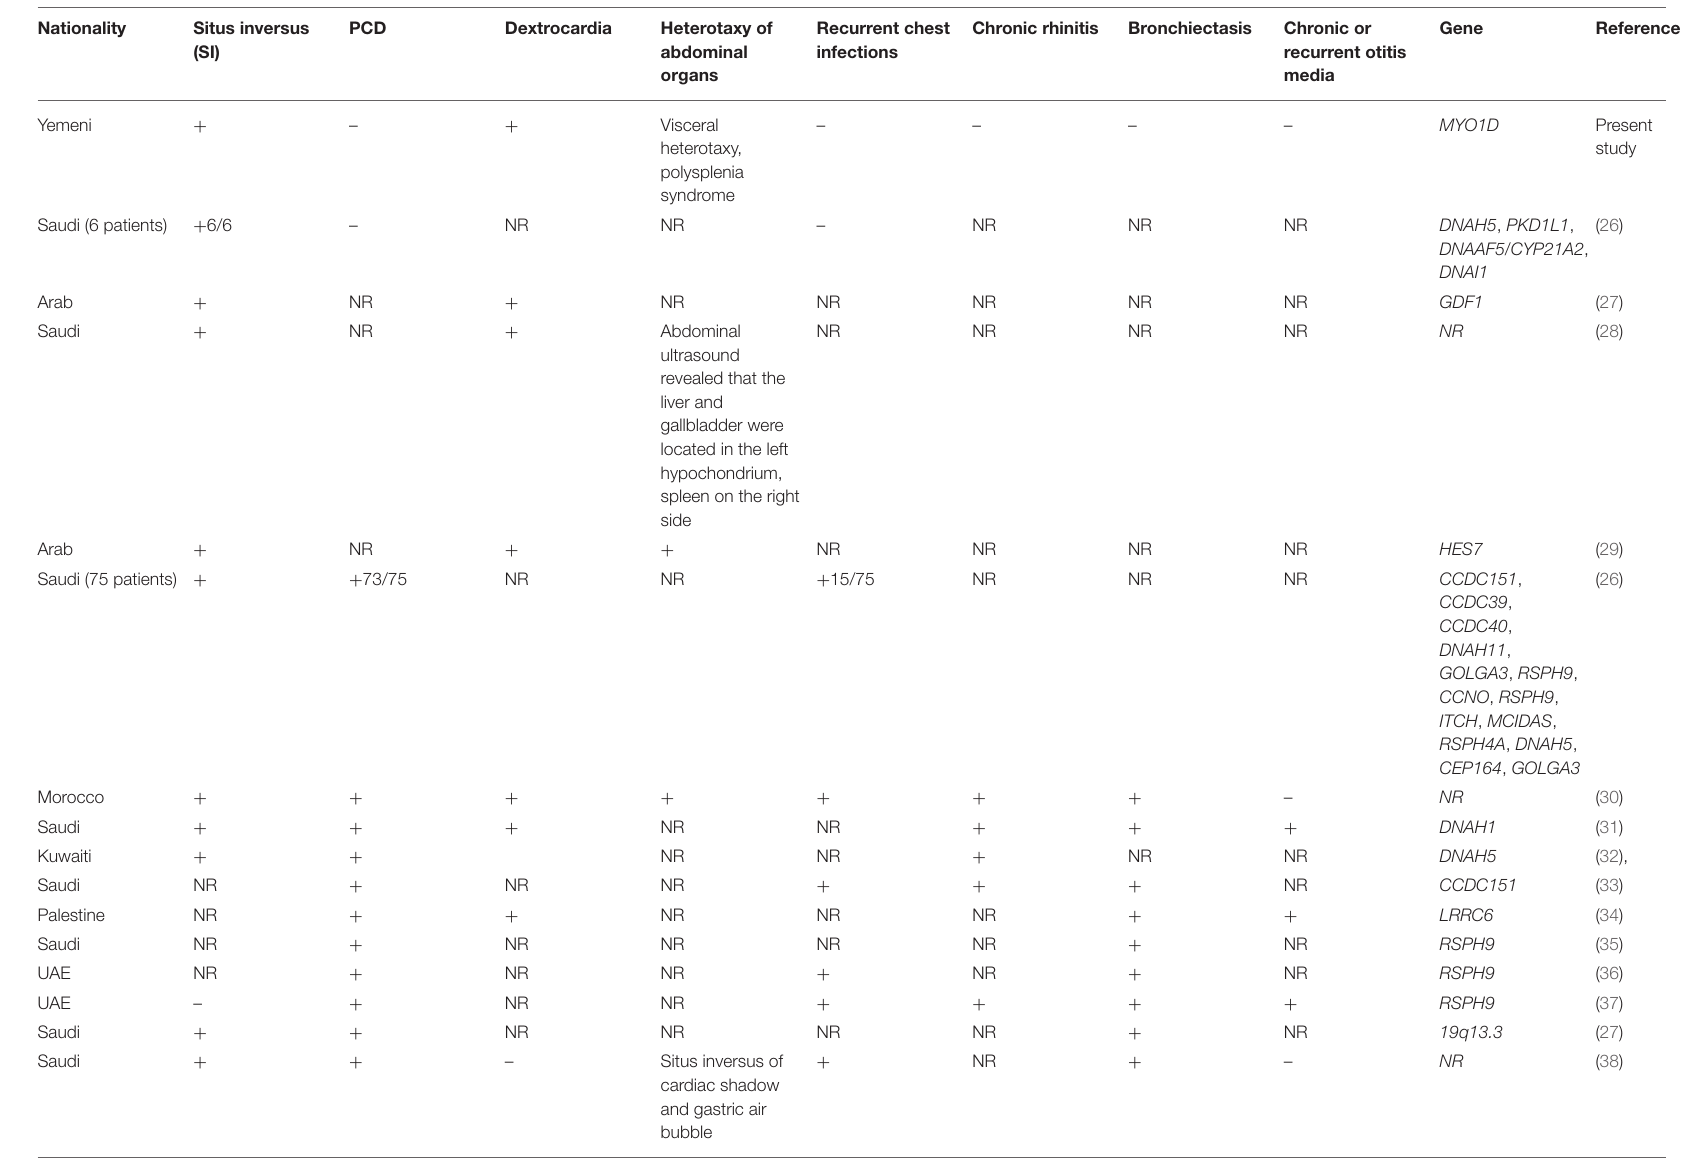
TABLE 3 | Phenotypes and genetic data of LD and/or PCD among Arabs.